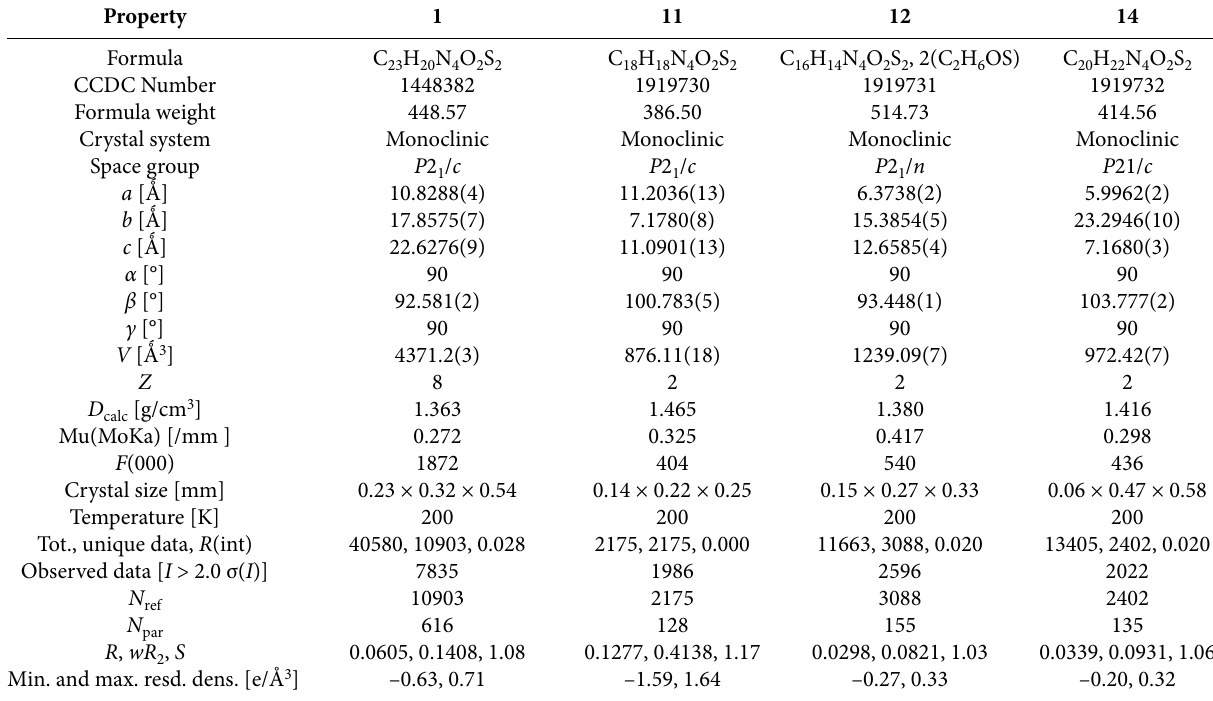
Table 3. Selected bond lengths (Å) and bond angles (°) for compounds 1 , 11 , 12 and 14 .